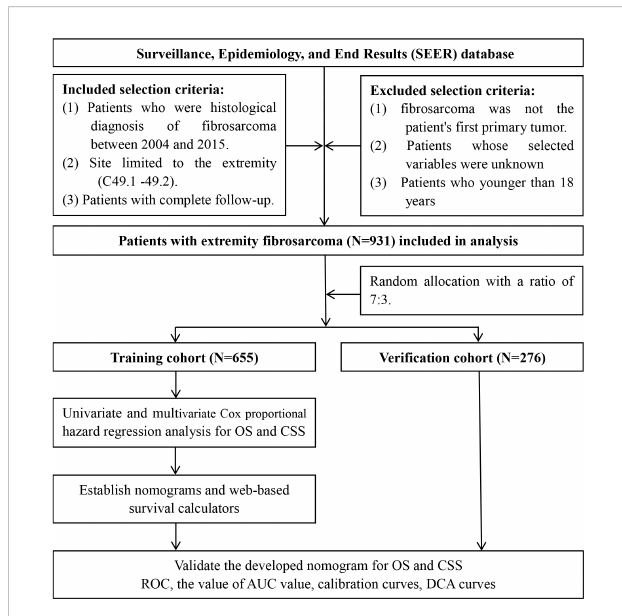
FIGURE 1 Flow diagram of selecting patient records from the Surveillance, Epidemiology, and End Results (SEER)